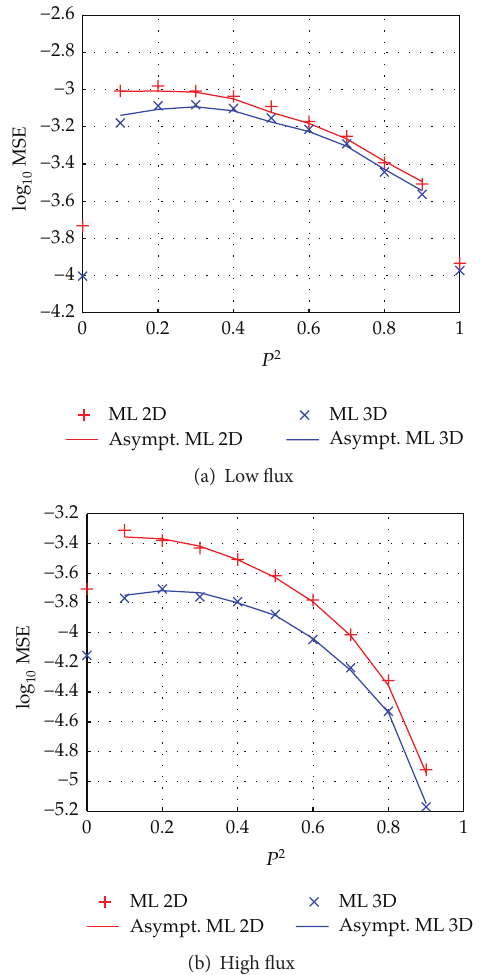
Figure 2: log MSE of the estimated square DoP 𝑃 2 using 2 or 3 intensity images versus the logarithm of the sample size for the matrices (a) Γ 2 and (b) Γ 8 (ML: maximum likelihood estimators, and Asympt. theoretical asymptotic value of the log MSE for a given